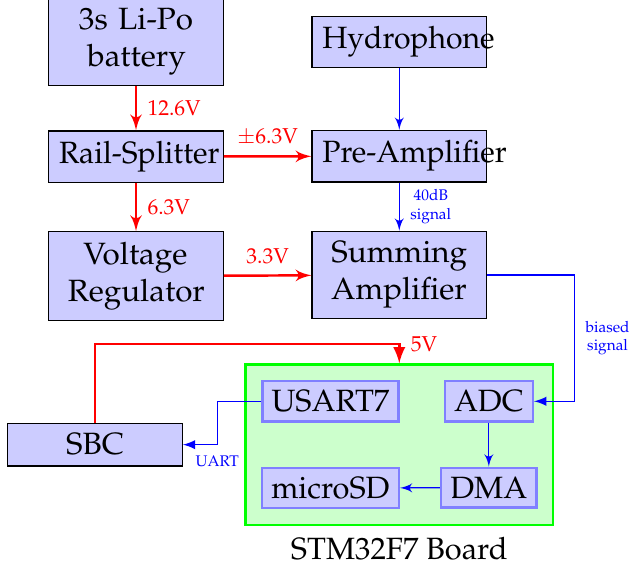
Figure 4. The block diagram of PorpDAQ. The preamplifier circuit is powered by a 3-cell Lithium-Polymer battery with a TL2426 “Rail-Splitter” creating a virtual ground between the rails. A 3.3 V voltage regulator is also used to provide power to the summing amplifier. The PorpDAQ is powered through USB and connected to the onboard